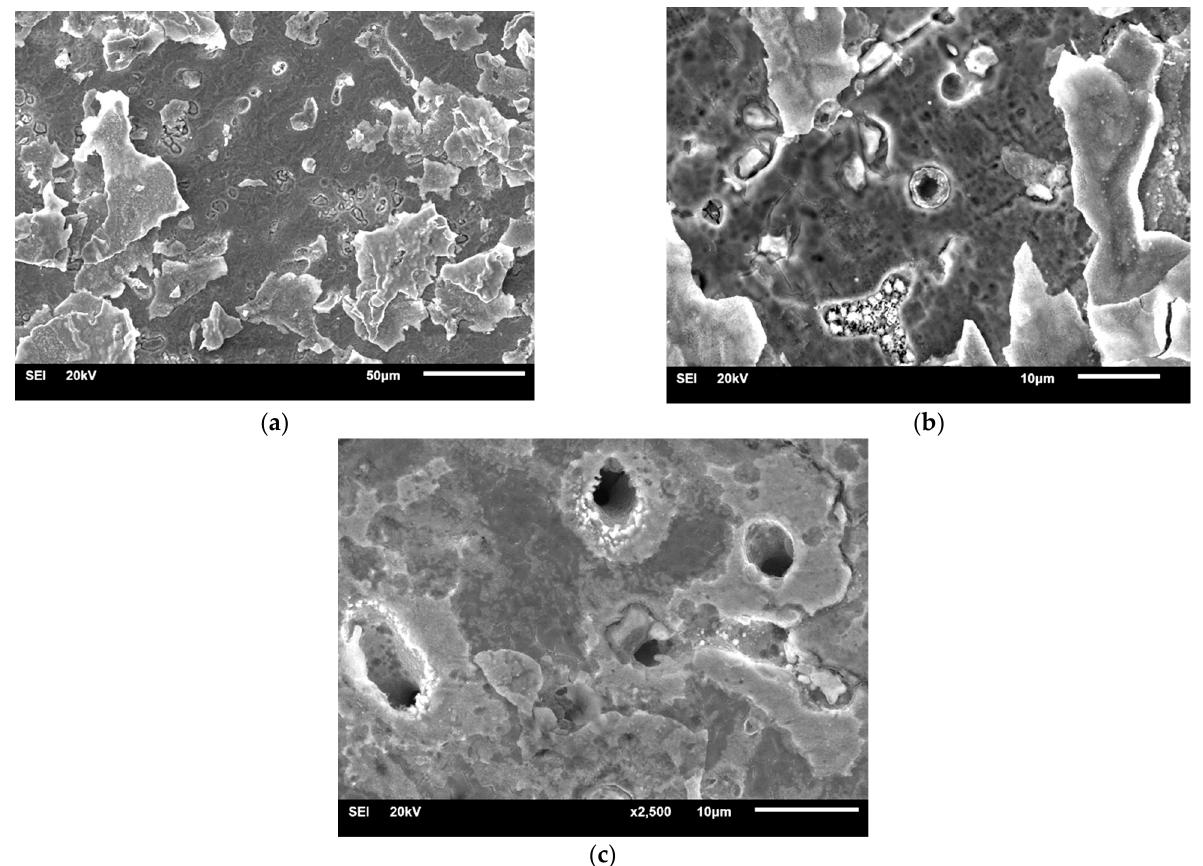
Figure 10. Morphology of MC-HT-Corr: ( a ) ×550; ( b ) ×2000, ( c ) ×2500.